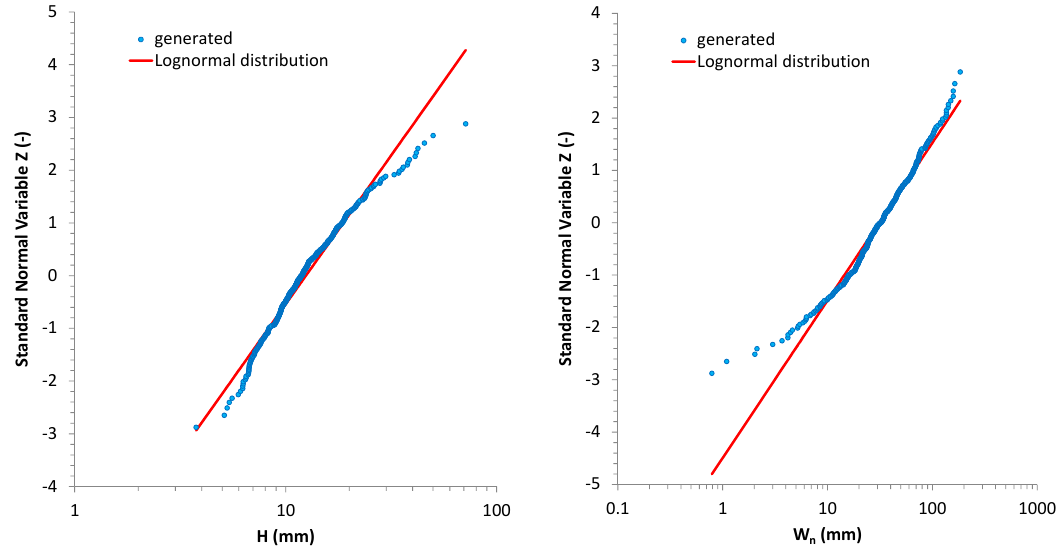
Figure 5. Lognormal probabilistic plot: comparison between empirical CDF and Lognormal distribution for both H ( left ) and n W ( right ).